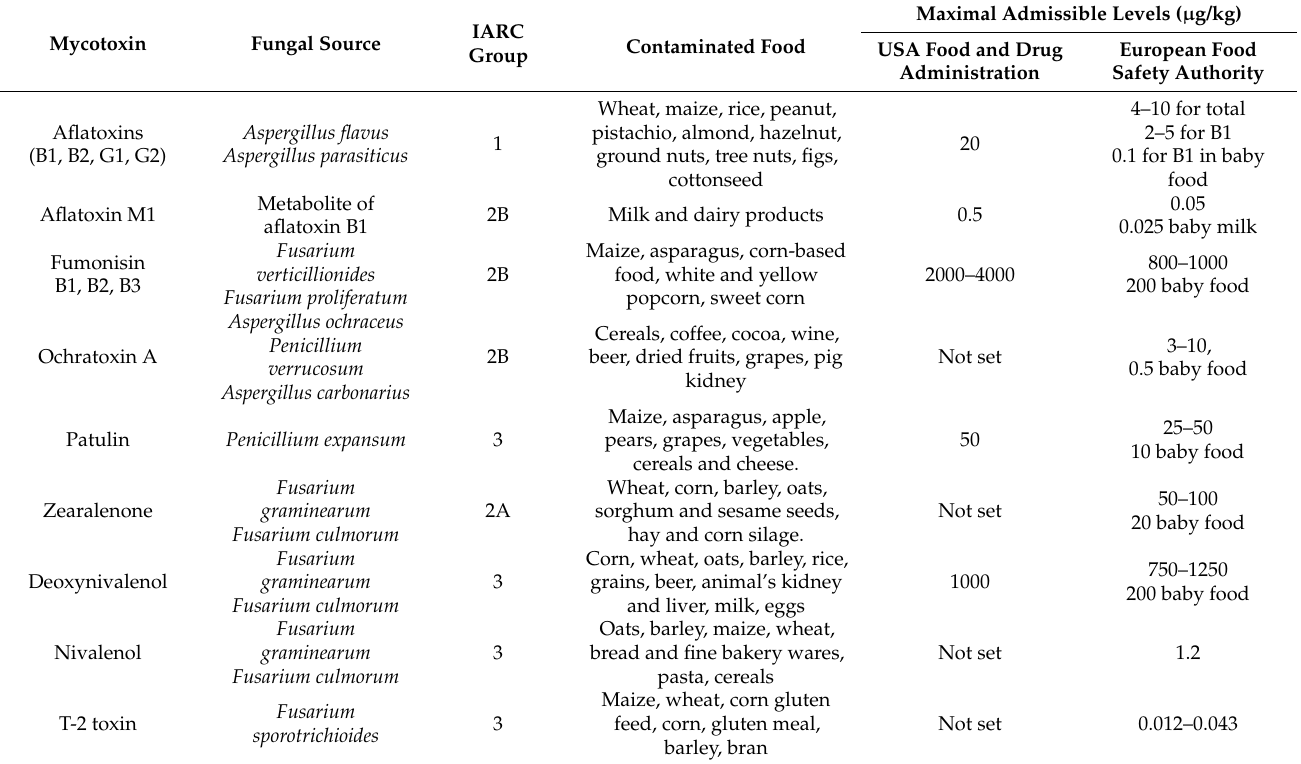
Table 1. Toxicity and maximal admissible levels of most important mycotoxins [32].